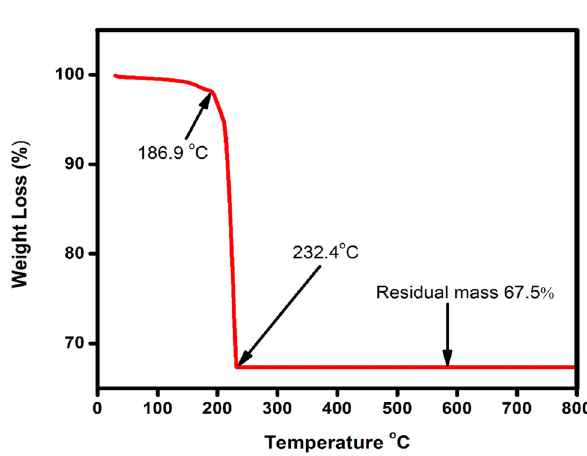
Figure A4: Thermogram of complex 1 showing weight loss as a function of